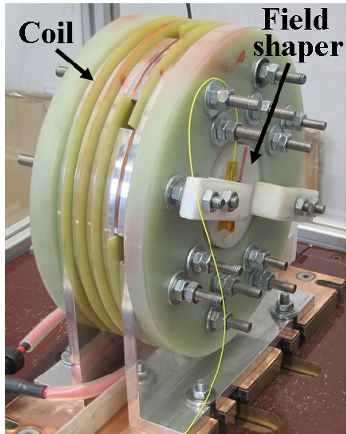
Figure 3. Actual arrangement of multi-turn bitter coil and field shaper with the collimator probe (yellow) of the photon Doppler velocimetry (PDV) setup coming out of the field shaper. The tube assembly is comprised of a flyer tube made of the Cu-DHP alloy with a diameter (d g ) equal to 22.22 mm and a wall thickness (e g ) equal to 0.89 mm, and a target tube made of 11SMnPb30 steel with a wall thickness (e h ) equal to 1 mm. The overlap between the flyer and the target tubes was equal to 25 mm, creating a free length of the flyer tube of 15 mm. The initial stando ff distance (s) between the flyer and the target tubes was varied from 1 to 2 mm, by employing target tubes with di ff erent external diameters (d h ) ranging from 18.44 to 16.44 mm.